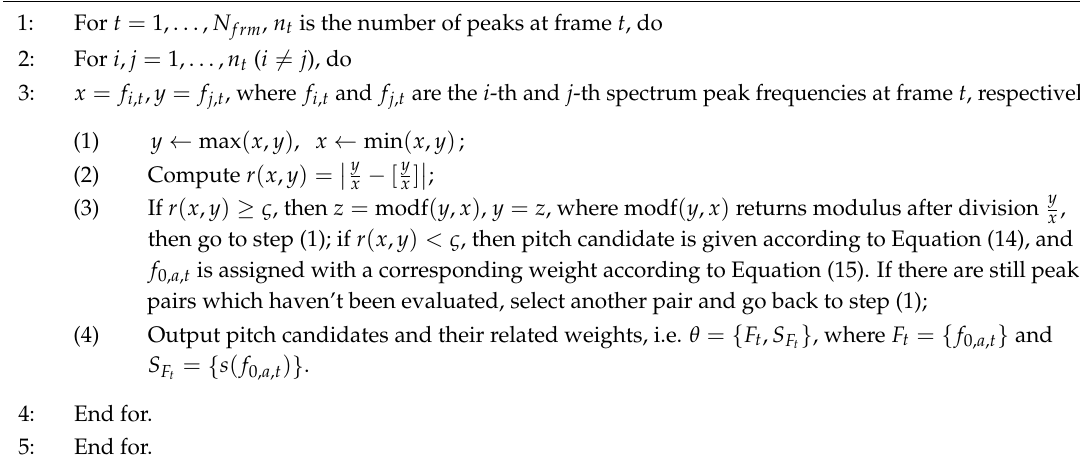
Algorithm 1. Computation for the parameters of pitch candidates: θ t = { F t , S F